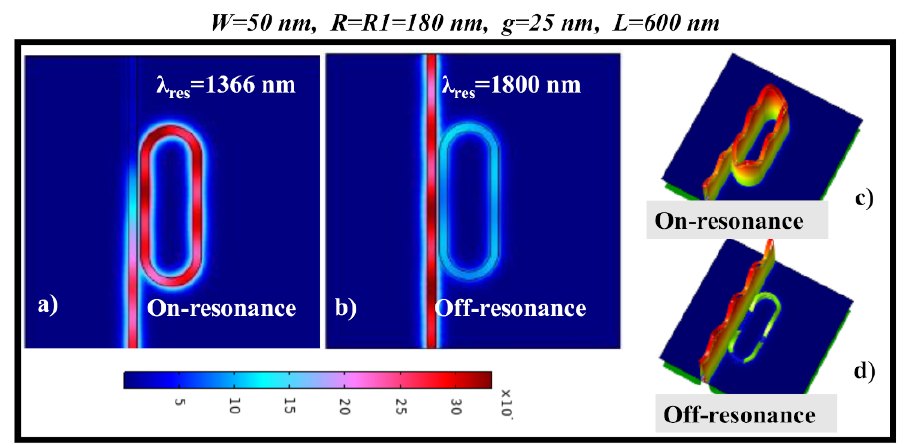
Figure 5. Normalized H-field distribution in the racetrack cavity: ( a ) on-resonance, ( b ) off-resonance. 3D-normalized H-field distribution in the racetrack integrated circular cavity: ( c ) on-resonance, ( d )